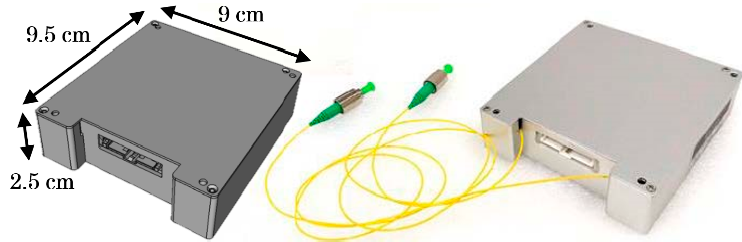
Figure 2. The 2-W EDFA’s 3D model ( left ) and flight model ( right ).